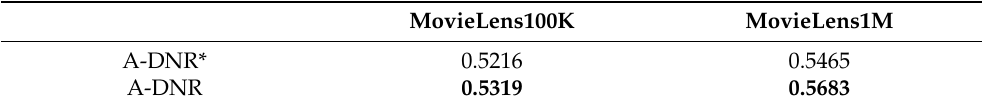
Table 8. The impact of user long-term and short-term preference fusion method on NDCG@10.